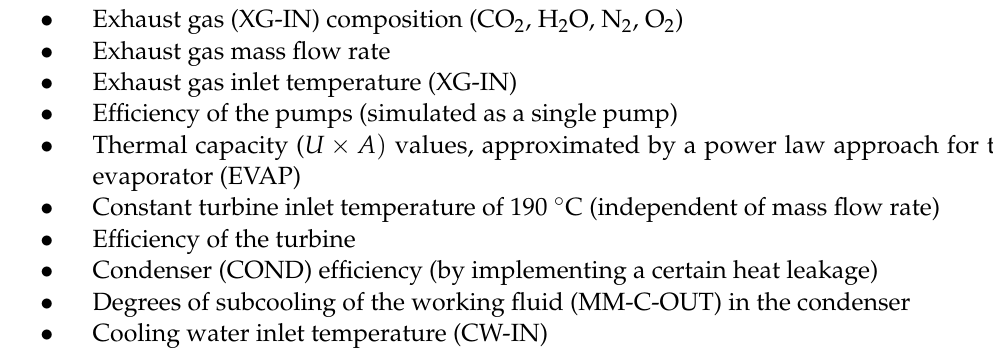
Figure 4. Main Flowsheet of the digital twin in ASPEN